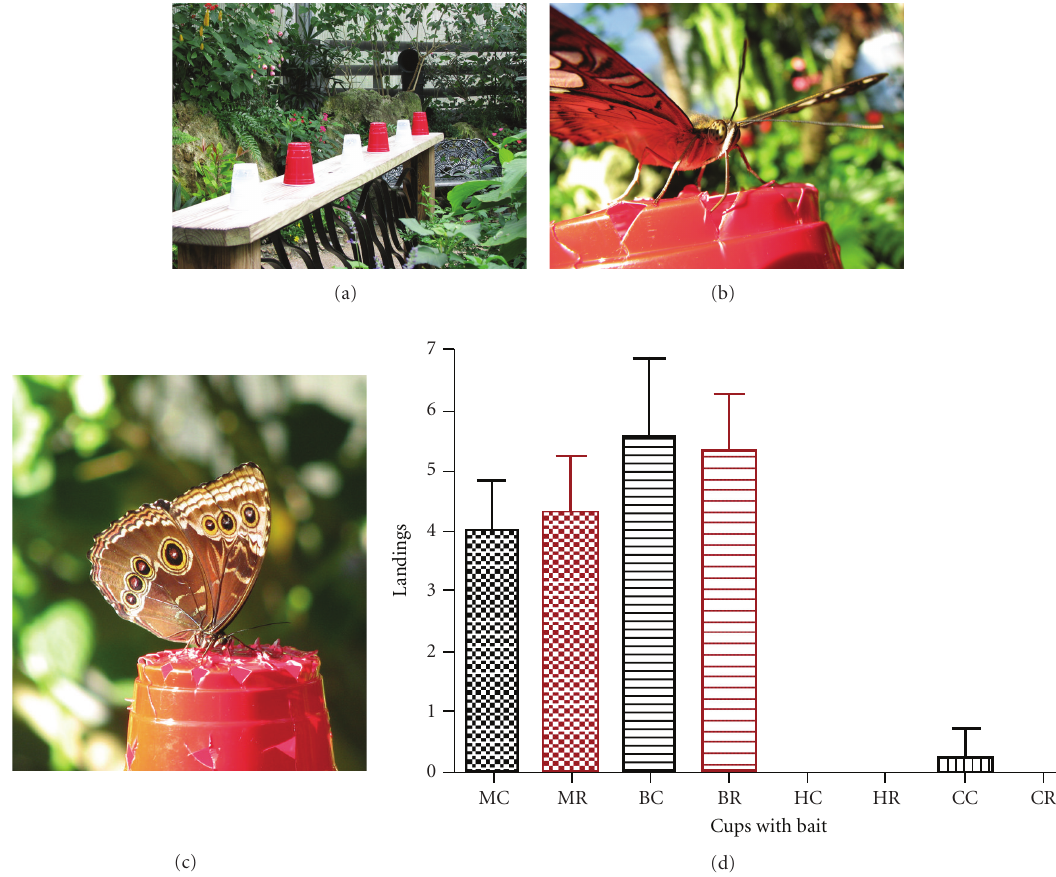
Figure 3: Bioassay II. (a-c) Scent stations attracting butterflies in the Butterfly Rainforest. (d) Graph showing the frequency of landings by Morpho helenor on bait stations emitting smells of mango (M), banana (B), or honey (H). C: clear cups, R: red cups. CC and CR are control (no bait)